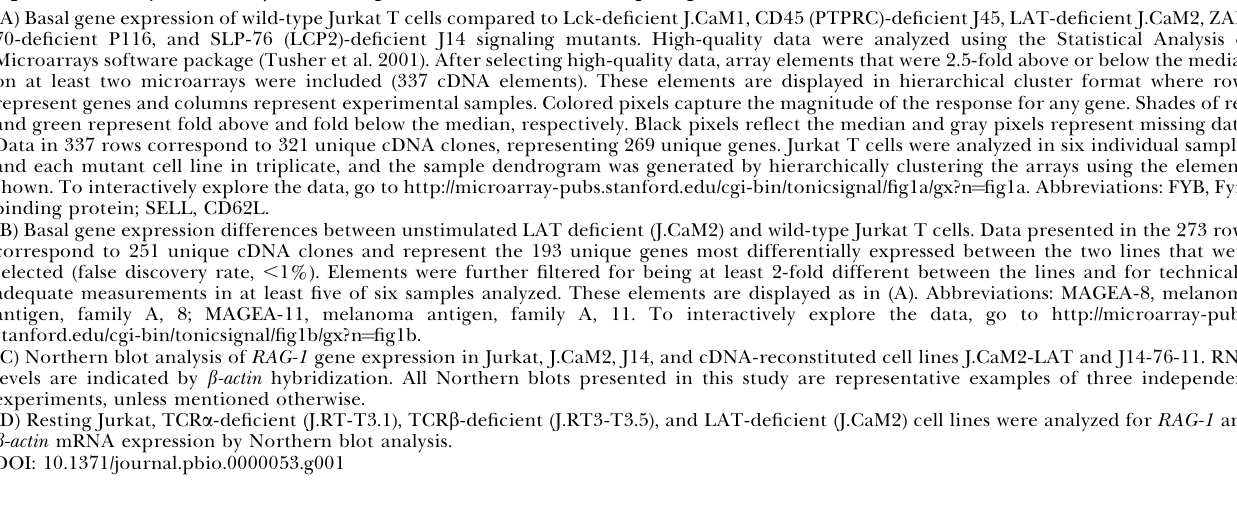
Figure 1. Gene Expression Analysis of Resting Jurkat T Cells and Derived Signaling Mutants (A) Basal gene expression of wild-type Jurkat T cells compared to Lck-deficient J.CaM1, CD45 (PTPRC)-deficient J45, LAT-deficient J.CaM2, ZAP- 70-deficient P116, and SLP-76 (LCP2)-deficient J14 signaling mutants. High-quality data were analyzed using the Statistical Analysis of Microarrays software package (Tusher et al. 2001). After selecting high-quality data, array elements that were 2.5-fold above or below the median on at least two microarrays were included (337 cDNA elements). These elements are displayed in hierarchical cluster format where rows represent genes and columns represent experimental samples. Colored pixels capture the magnitude of the response for any gene. Shades of red and green represent fold above and fold below the median, respectively. Black pixels reflect the median and gray pixels represent missing data. Data in 337 rows correspond to 321 unique cDNA clones, representing 269 unique genes. Jurkat T cells were analyzed in six individual samples and each mutant cell line in triplicate, and the sample dendrogram was generated by hierarchically clustering the arrays using the elements shown. To interactively explore the data, go to http://microarray-pubs.stanford.edu/cgi-bin/tonicsignal/fig1a/gx?n ¼ fig1a. Abbreviations: FYB, Fyn- binding protein; SELL, CD62L. (B) Basal gene expression differences between unstimulated LAT deficient (J.CaM2) and wild-type Jurkat T cells. Data presented in the 273 rows correspond to 251 unique cDNA clones and represent the 193 unique genes most differentially expressed between the two lines that were selected (false discovery rate, , 1%). Elements were further filtered for being at least 2-fold different between the lines and for technically adequate measurements in at least five of six samples analyzed. These elements are displayed as in (A). Abbreviations: MAGEA-8, melanoma antigen, family A, 8; MAGEA-11, melanoma antigen, family A, 11. To interactively explore the data, go to http://microarray-pubs. stanford.edu/cgi-bin/tonicsignal/fig1b/gx?n ¼ fig1b. (C) Northern blot analysis of RAG-1 gene expression in Jurkat, J.CaM2, J14, and cDNA-reconstituted cell lines J.CaM2-LAT and J14-76-11. RNA levels are indicated by b -actin hybridization. All Northern blots presented in this study are representative examples of three independent experiments, unless mentioned otherwise. (D) Resting Jurkat, TCR a -deficient (J.RT-T3.1), TCR b -deficient (J.RT3-T3.5), and LAT-deficient (J.CaM2) cell lines were analyzed for RAG-1 and b -actin mRNA expression by Northern blot analysis. DOI: